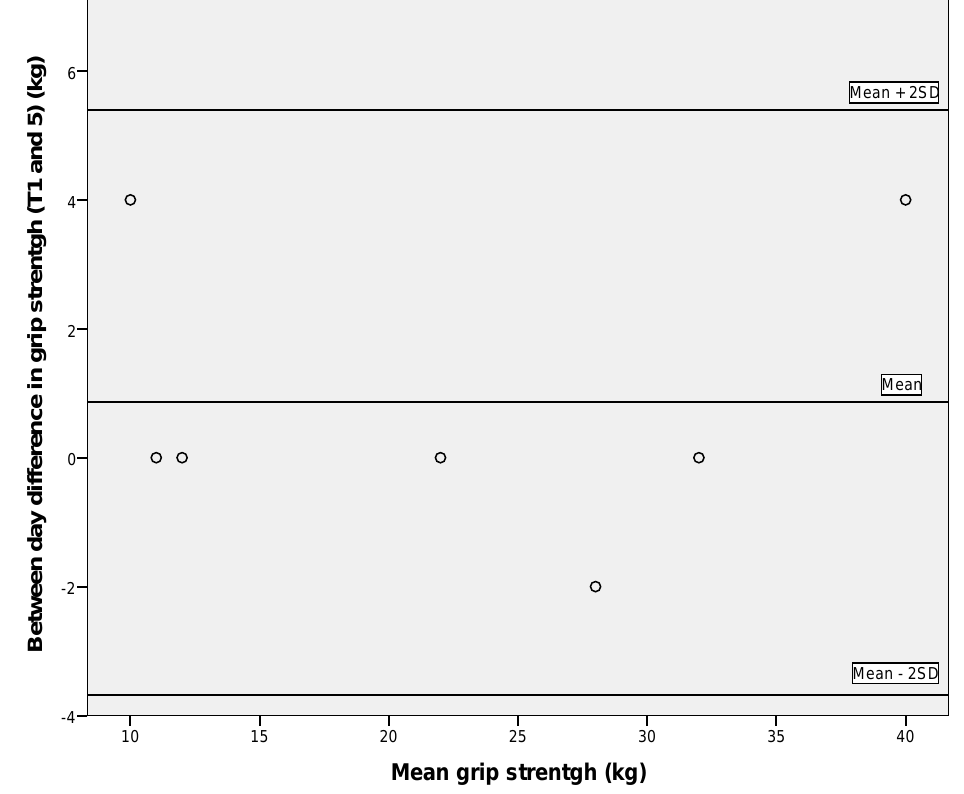
Figure 6. Bland–Altman plot showing between day variation for grip strength between time point 1 and